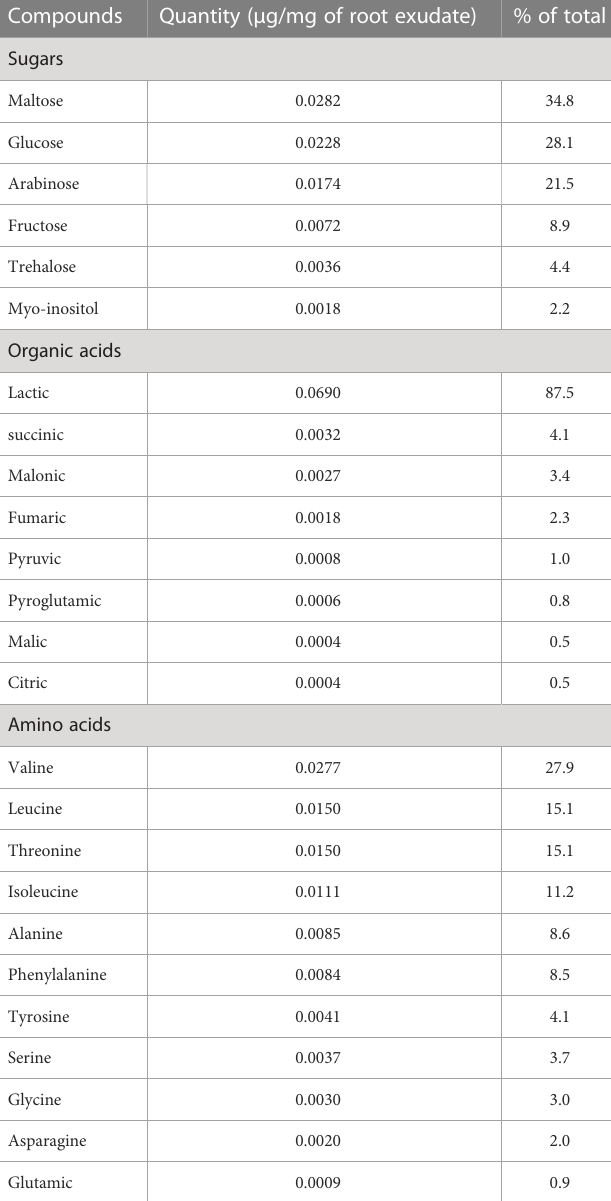
TABLE 2 Quantity of soluble sugars, organic acids and amino acids detected by GC-MS in root exudates collected from 15 days-old plants of A. hypogea cultivar JL24 grown in